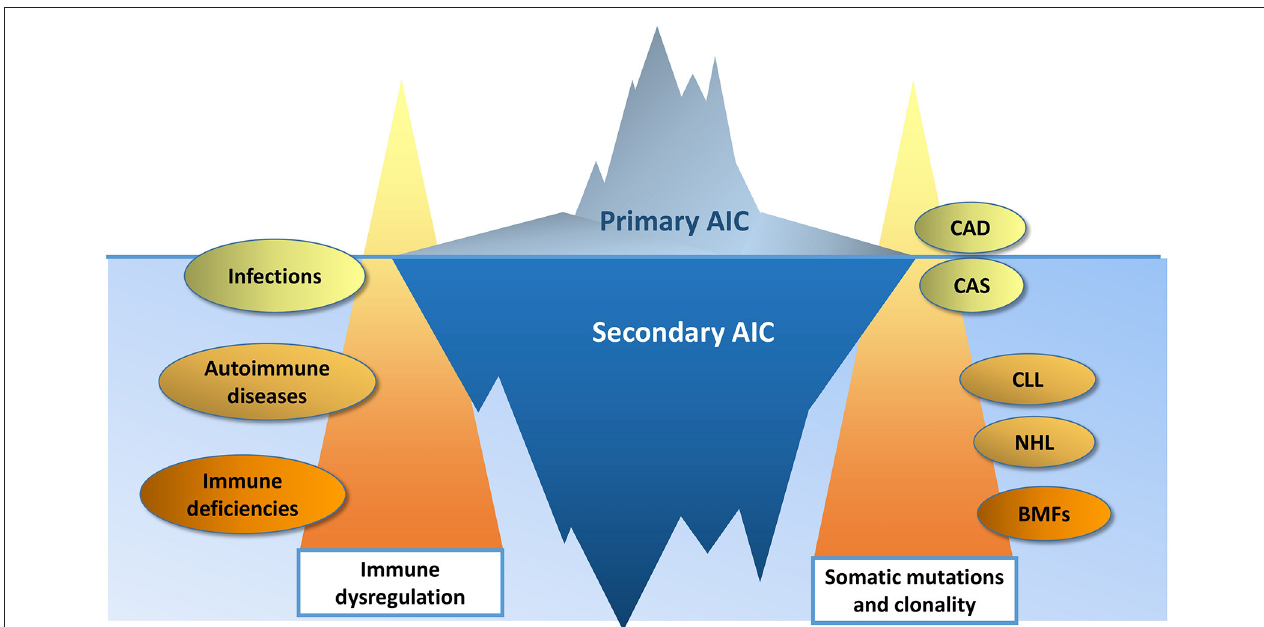
FIGURE 2 | The changing border between primary and secondary autoimmune cytopenias (AIC). Immune dysregulation is more profound in AIC secondary to systemic autoimmune diseases and immune deficiencies, than in AIC secondary to infections. Likewise, a higher burden of somatic mutations is more typical of bone marrow failures (BMF) and lymphoproliferative disorders (chronic lymphocytic leukemia, CLL; non-Hodgkin lymphomas, NHL), than in cold agglutinin disease (CAD) and syndrome (CAS). The increasing availability of genomic testing will improve the diagnostic sensitivity, moving upward the border between primary and secondary